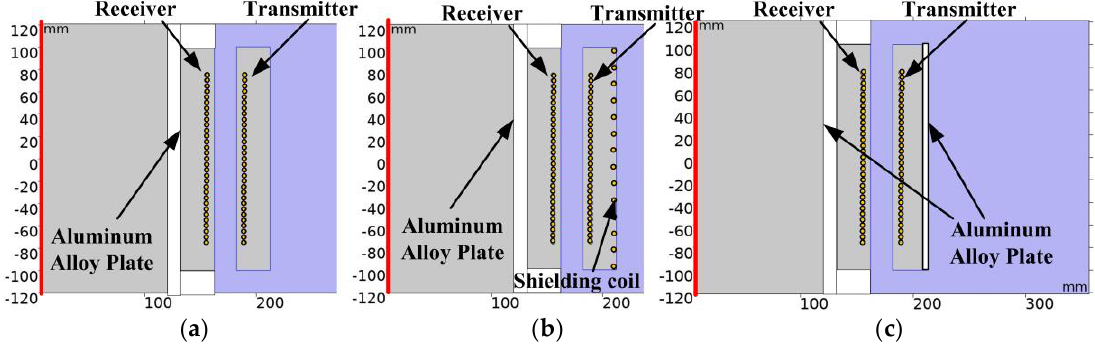
Figure 9. Simulation geometric models for WPT system. The blue purple area means seawater, gray area is air, the white area is aluminum alloy plate, coils are made of copper and the red lines are the rotary axis. ( a ) The underwater WPT system without shield. ( b ) The underwater WPT system with a shielding coil. ( c ) The underwater WPT system with metallic plate as shield.